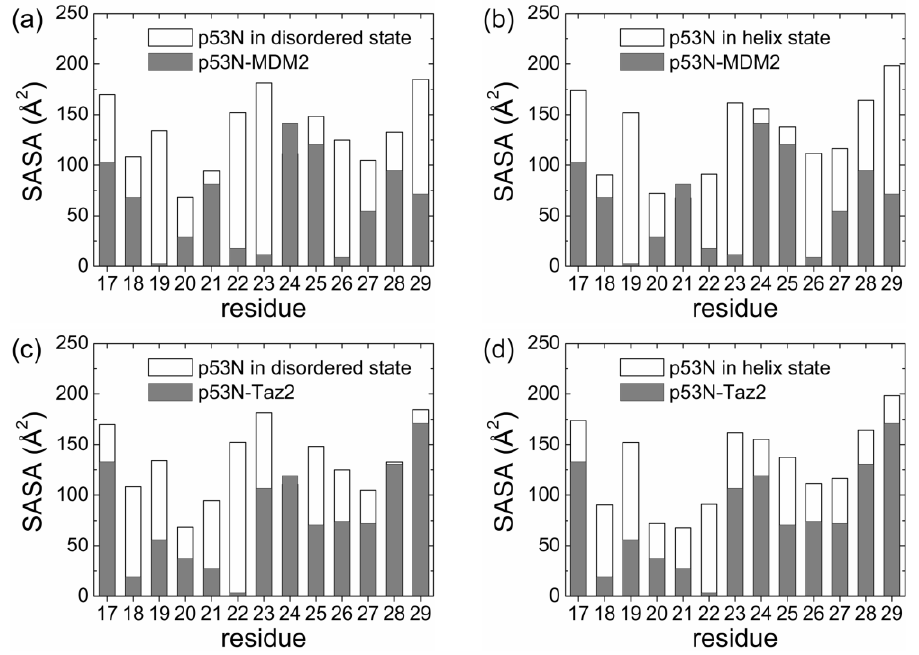
Figure S1. SASA analysis of the p53N in the disordered state ( a , c ) and the helix state ( b , d ) using the simulated trajectories. For comparison, the corresponding values of SASA in the complex states are